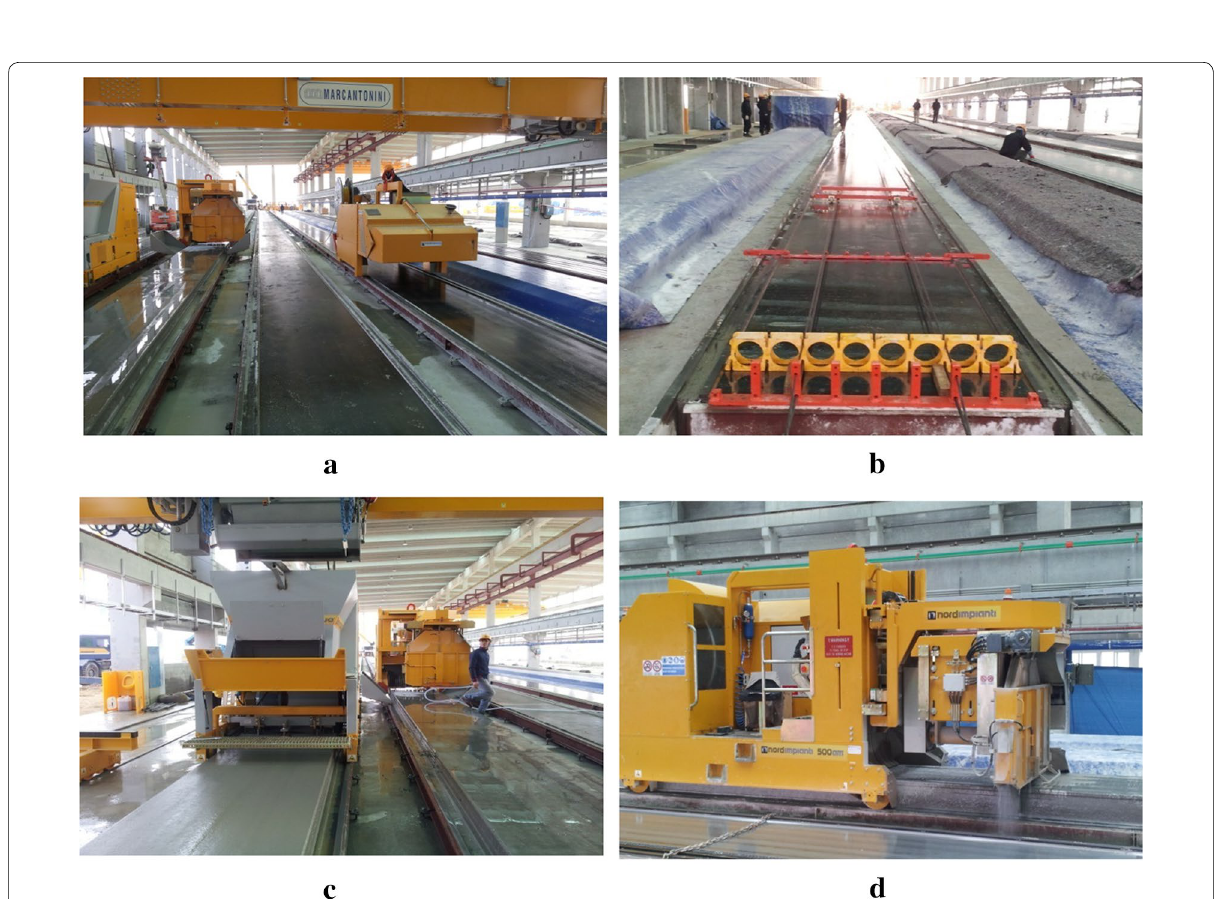
Fig. 2 Description of extrusion method (dry‑cast method). a Cleaning bed, b prestressing tendons, c casting by extruder machine, d cutting